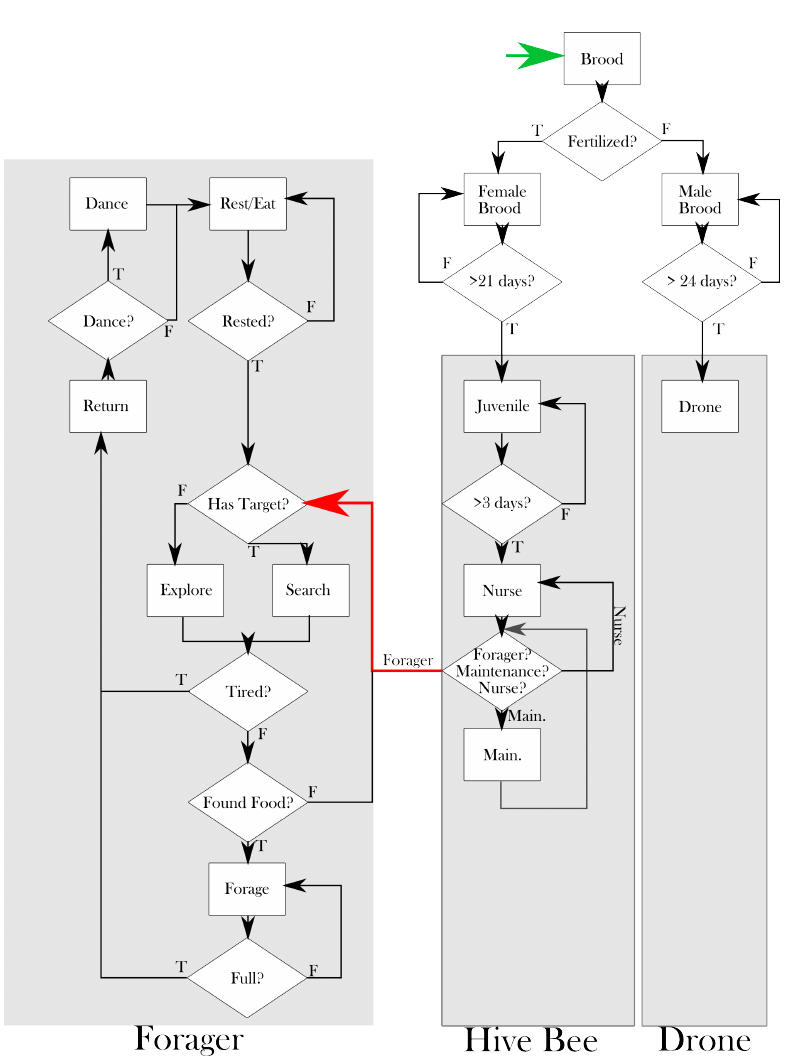
Figure 2. Flow diagram of the three main bee classes and their possible decisions in one time step. This diagram is not exhaustive, but intended to be illustrative of the main decision tree for each of the three main classes: drones , hive bees , and foragers . These classes of bees are further divided into different states, which changes the behaviours and parameters associated with each bee. The green arrow begins the cycle for one bee agent. The queen lays an egg, which then gets added to the Brood . The Brood are either fertilized (female) or not (male). After 21 days, the fertilized brood will emerge and become juveniles . Hive bee: The juveniles are responsible for cleaning cells. After three days, the hive bee juvenile will become a nurse . The nurses are responsible for caring for the brood, ensuring their survival. At each time point, the nurse will decide to become a maintenance bee, remain a nurse or become a forager . The maintenance bees are responsible for hive repair, security and other duties around the hive that are specifically not caring for brood. Maintenance bees can also revert to nurse bees if there is a need, or be recruited ( red arrow ) to the forager class. The probability of the bee choosing one of these three states is dependent on the needs of the hive, the bee’s age and many other factors (pesticide exposure, disease, weather etc.). The forager class is typically an ‘end of life’ class. Bees recruited to forager will leave the hive. If they have a target, the bee will search out the target. If the bee does not have a target or loses its target, it will explore . A bee who is tired (i.e., runs out of energy) will return to the hive. If a bee has found food , it will begin to forage in that patch. When the bee is full , it will return to the hive. In the hive, the bee may decide to dance to relay the location of a food source to other bees. Whether or not a bee dances, she will always rest . Once rested, the forager will again leave the hive to forage. Drones: After 24 days, an unfertilized egg will develop into a drone. Currently, drones in Bee++ stay in the hive and consume resources until they die or are ejected by the females. At each state, the bee has a probability of death, which has been omitted from the diagram for